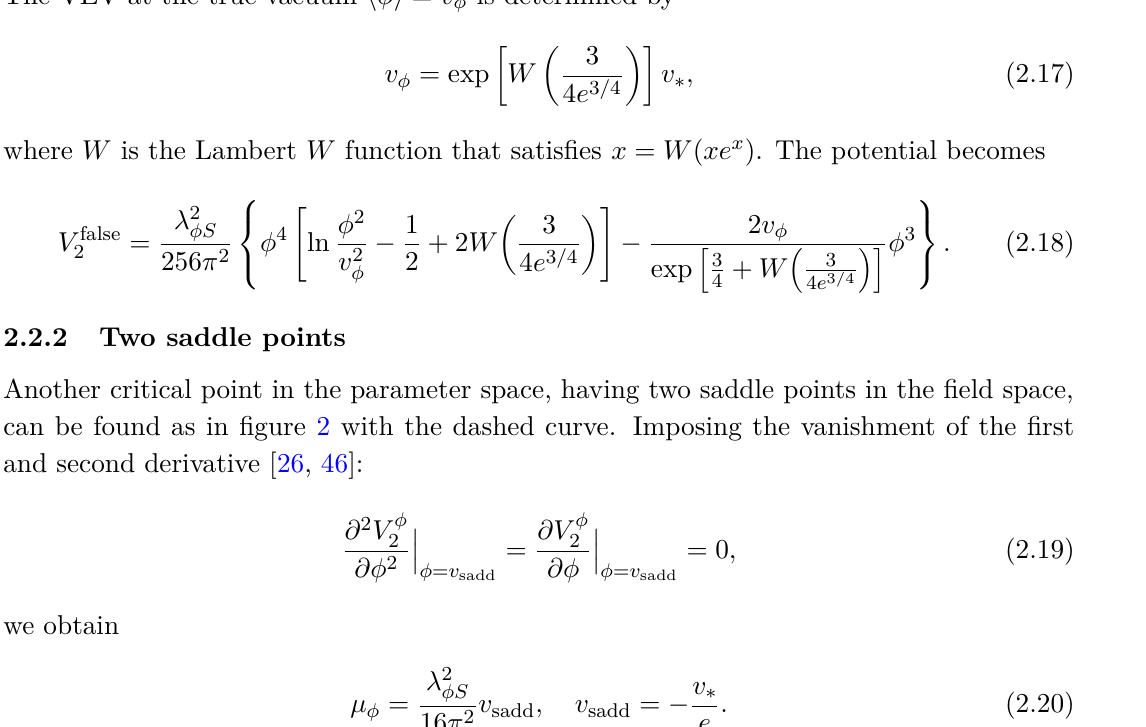
Figure 2 . Shape of the scalar potential without the Z 0 the CP 2-2 (dashed curve), where the right panel is a zoom-up version at around the origin.